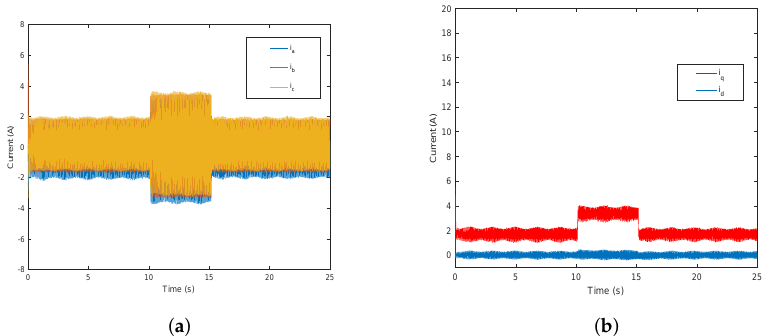
Figure 10. Experimental current curves based on GPC+ESO method under load disturbance. ( a ) three-phase current response curves; ( b ) d - q axis current response curves.